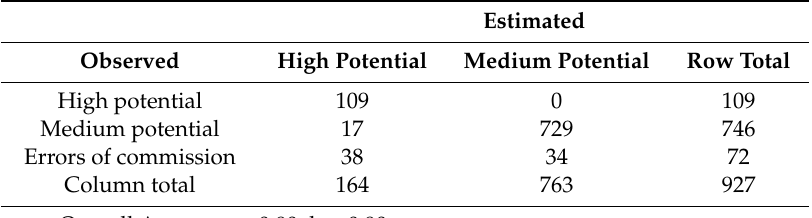
Table 20. Error matrix of the MCDA analysis in scenario